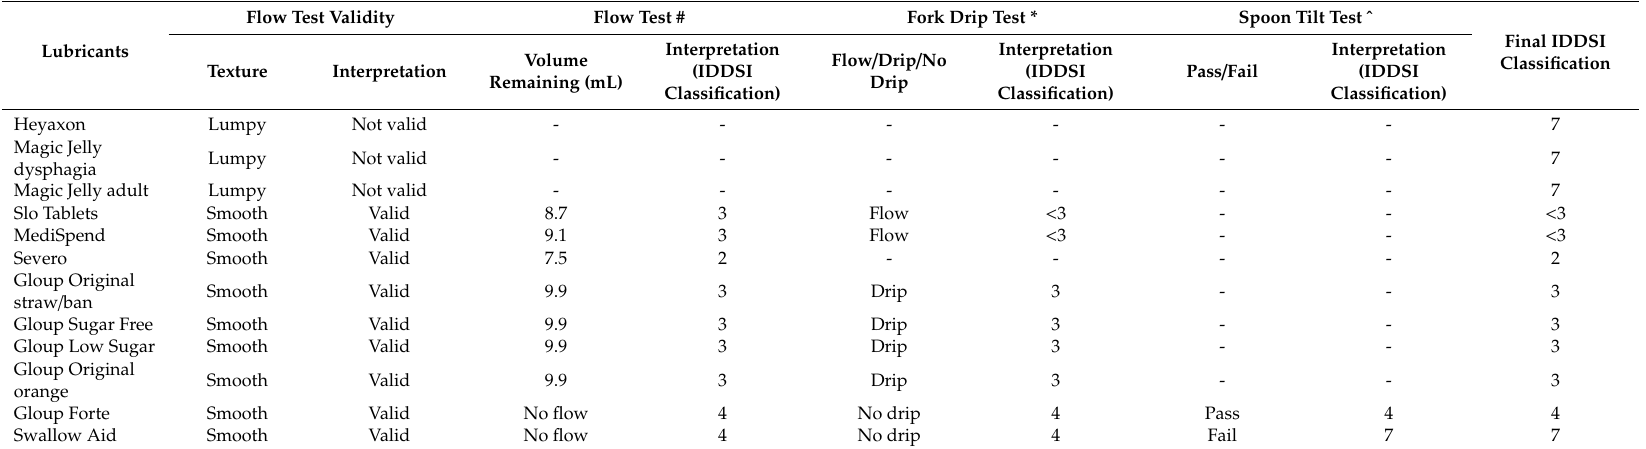
Table 2. Medication lubricant classification according to IDDSI testing methods at room temperature (24 ◦ C). Flow test validity (for fluids at all levels): smooth fluids are valid to be tested using the Flow test, while fluids that contain gristle, bone, husks, shell, fibres or lumps are not valid to be tested. Flow test (for fluids at all levels): the volume of fluid remaining in the syringe after 10 s. Fork Drip test (for fluids at level 3 and 4 in the Flow test): fluid drip and flow manner through fork prongs. Spoon Tilt test (for fluids at level 4 in the Fork Drip test): ability of fluid to hold its shape on the spoon and slide o ff easily when spoon is